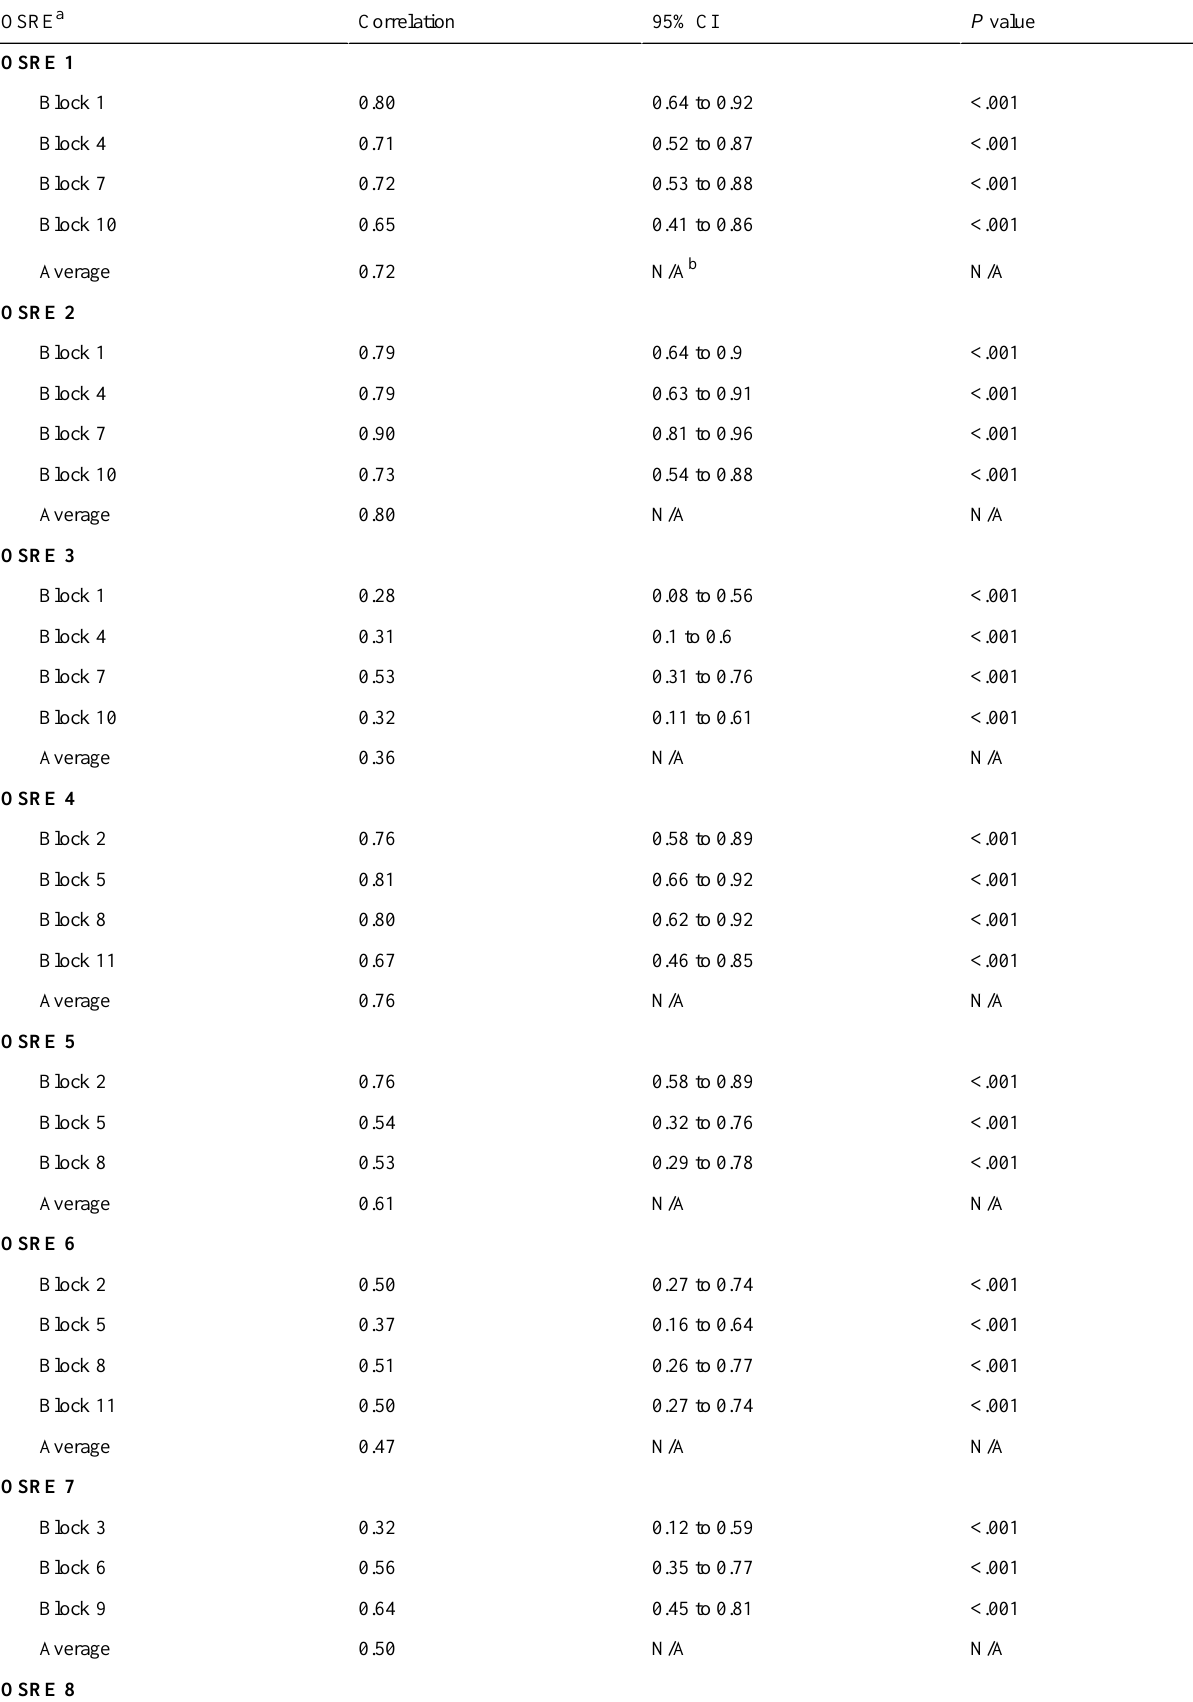
Table 3. Interrater reliability among graders with intraclass correlation